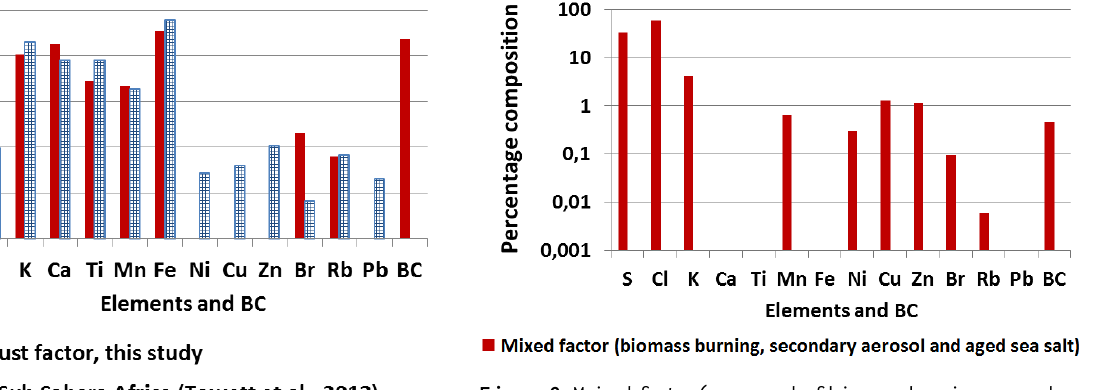
Figure 9. Mixed factor (composed of biomass burning, secondary aerosol and aged sea salt components) from the analysis of sam- pled PM 2 . 5 marked by high concentration of S and Cl as well as substantial concentration of